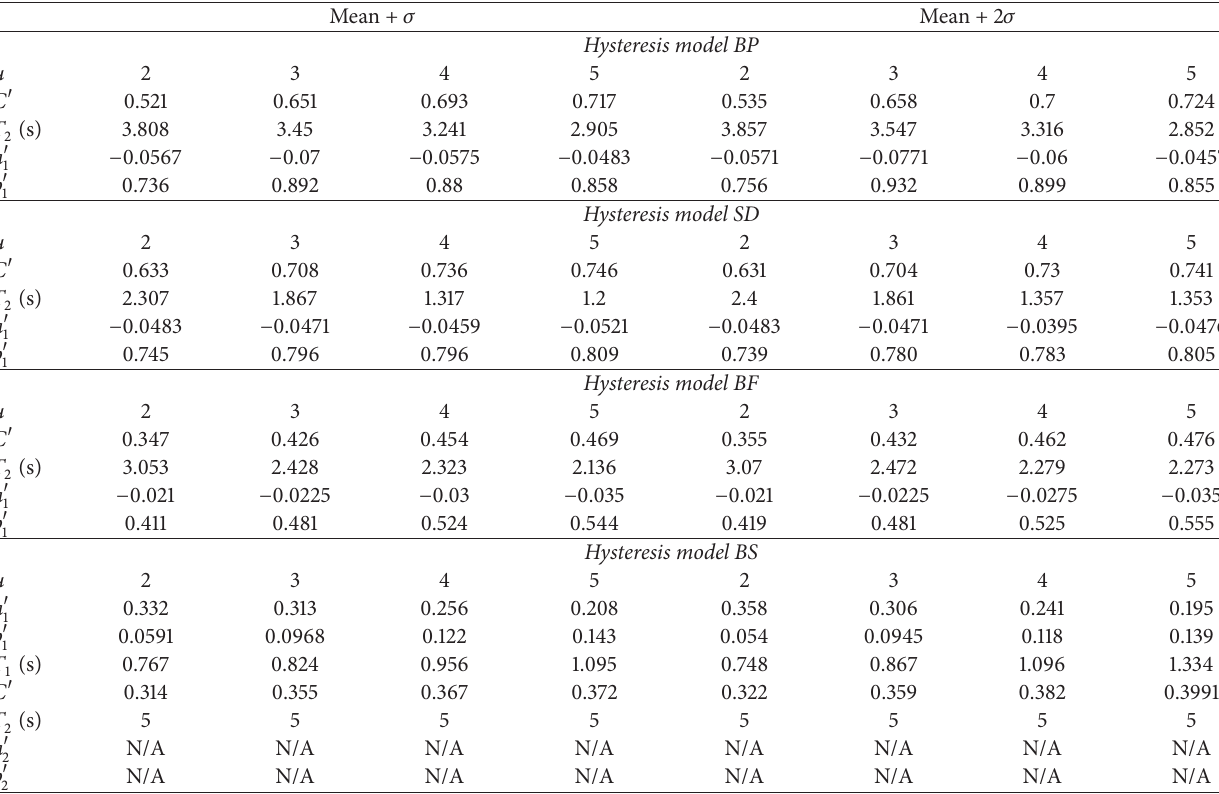
Table 15: HE/IE spectra shape parameters for site class